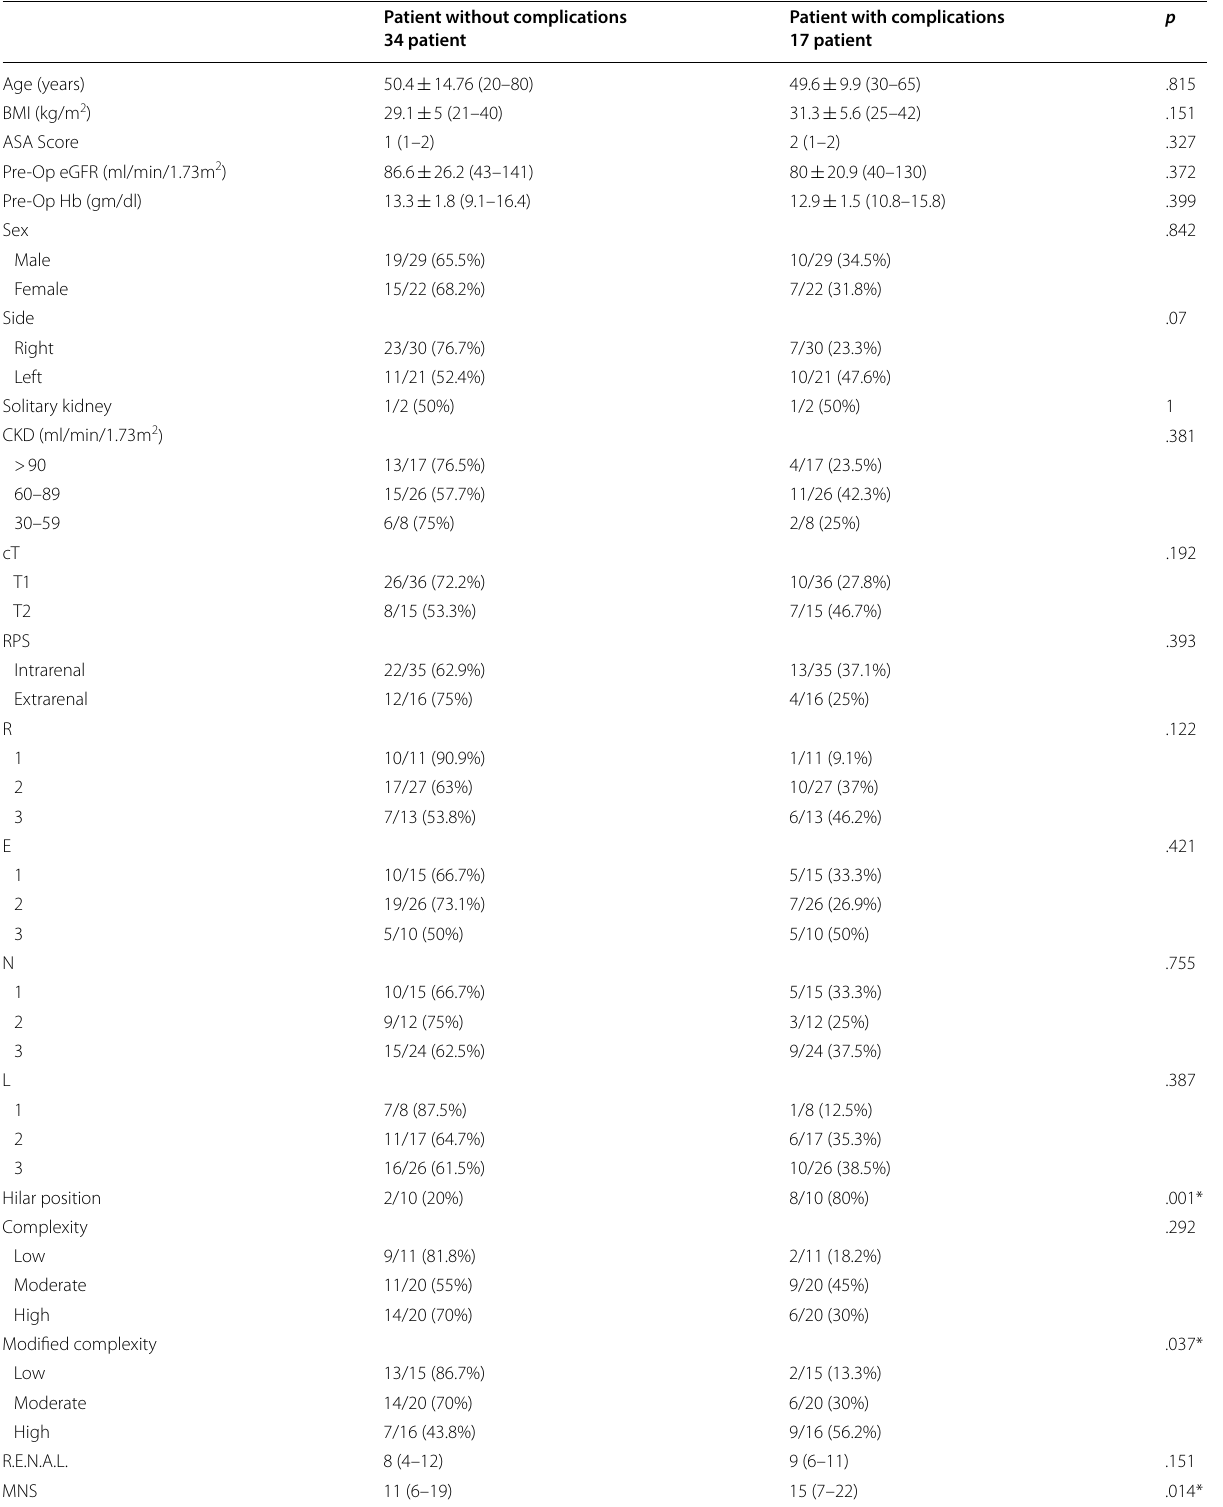
Table 5 Predicting factors for postoperative